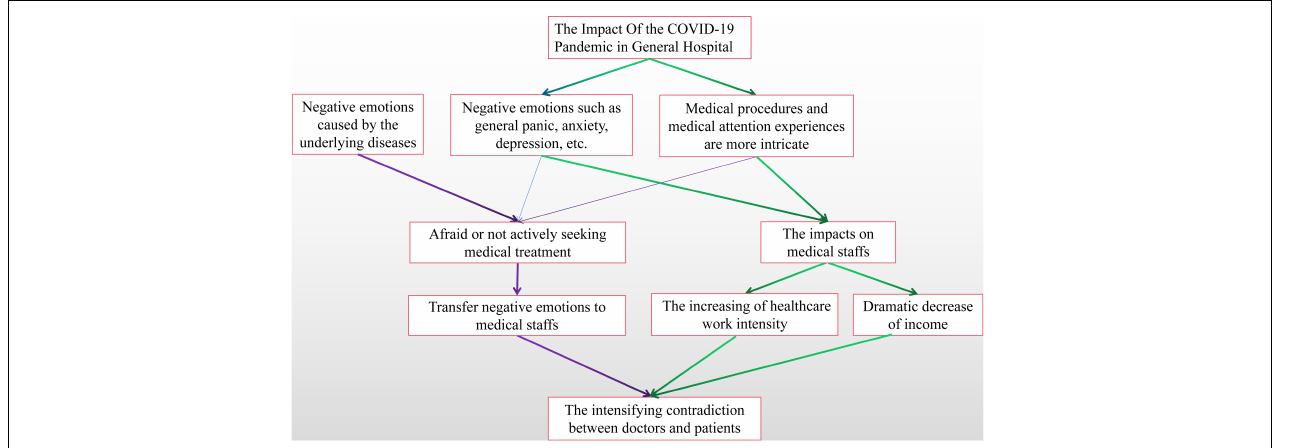
FIGURE 1 | Analysis of psychological factors affecting patients in general